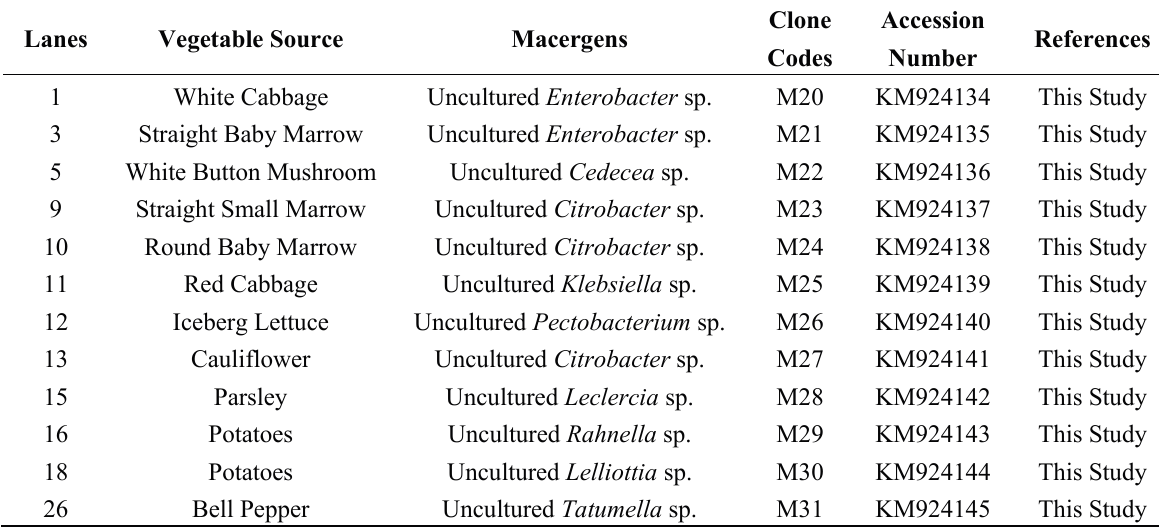
Table 3. Macergens detected by Set 2 primers from the rotten vegetables.